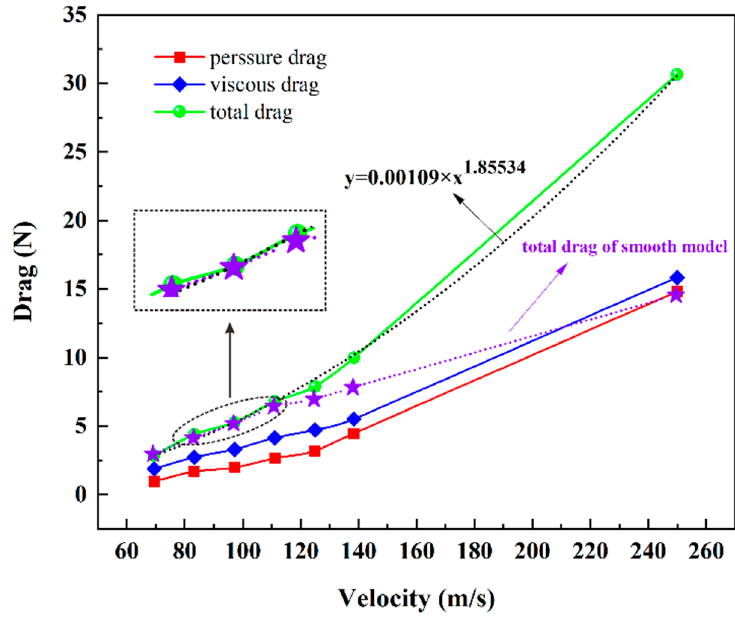
Figure 3. Variations of drag with increasing flow velocity.